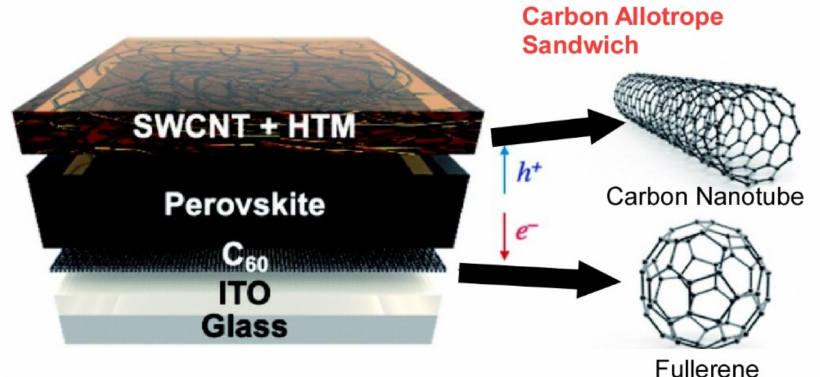
Figure 8. Perovskite solar cell fabricated by sandwiching a perovskite layer between two carbon allotropes: C 60 and carbon nanotubes. Reprinted with permission from [152]. Copyright 2021, Chemical Society of